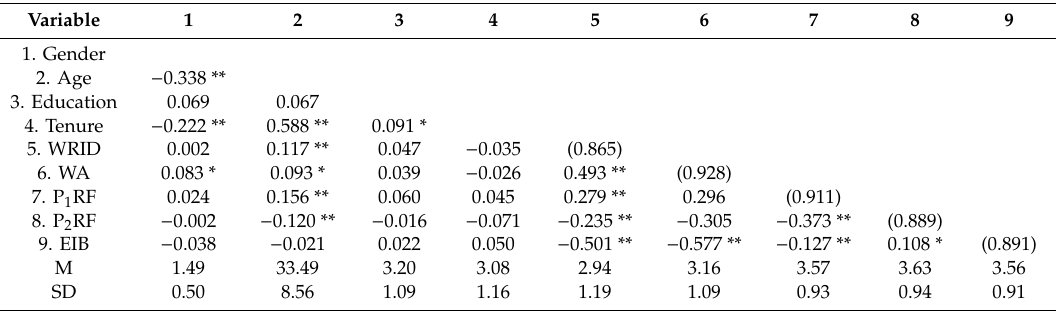
Table 1. Descriptive statistical analysis and correlations ( N =